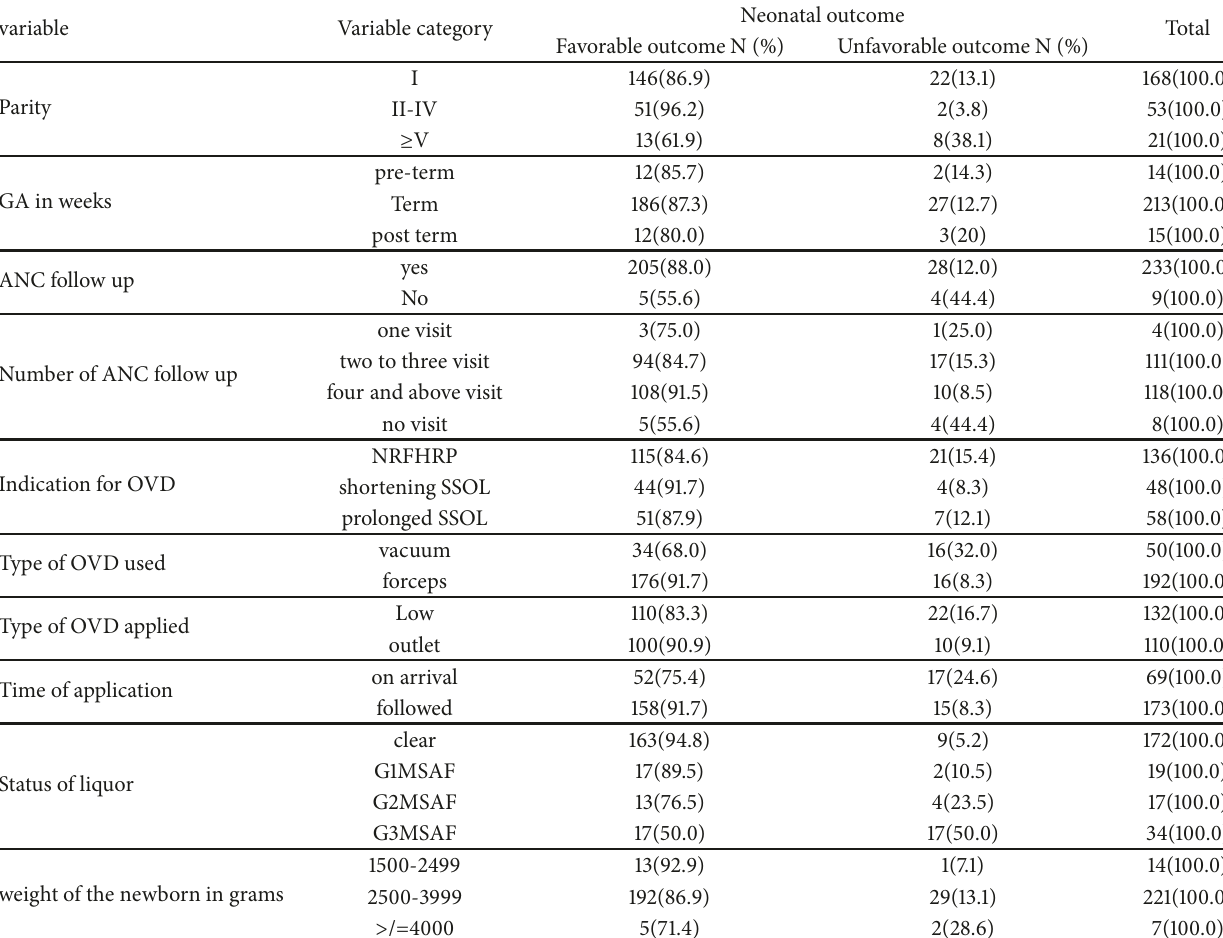
Table 4: Distribution of neonatal outcome among mothers who gave birth by OVD in JUMC December 1, 2016–May 30,